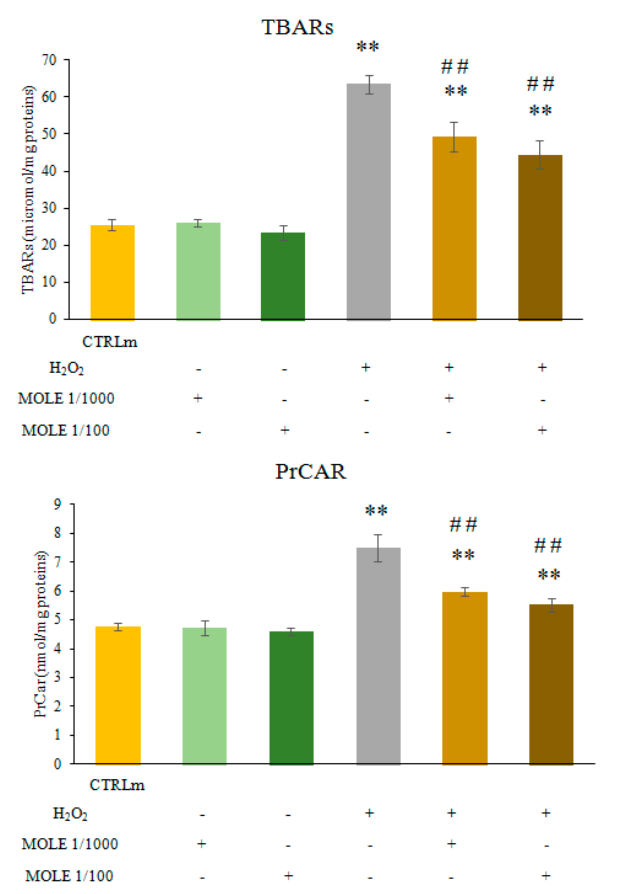
Figure 4. Thiobarbituric acid reactive substances (TBARs) and protein carbonyls (PrCar) analysis. Measurement of TBARs and PrCar analysis was performed in C2C12 myotubes treated with MOLE stock solution dilutions (1/1000 and 1/100 working solution) or vehicle (methanol) in culture media for 24 h and in samples treated for a further hour with hydrogen peroxide (1 mM) with pre-treatment with vehicle or MOLE. Data presented are the mean ± S.D. of three experiments. ** p < 0.01 vs. CTRLm; ## p < 0.01 vs. H 2 O 2 .